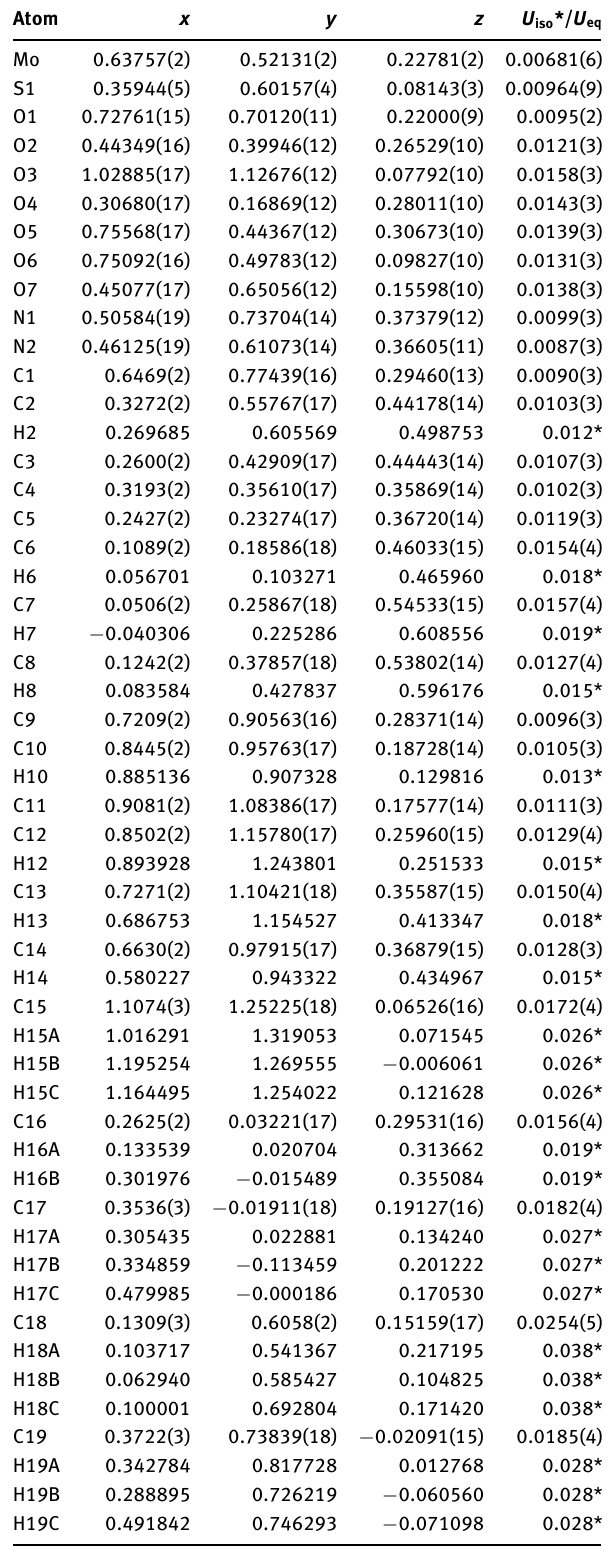
Table 2: Fractional atomic coordinates and isotropic or equivalent isotropic displacement parameters (Å 2